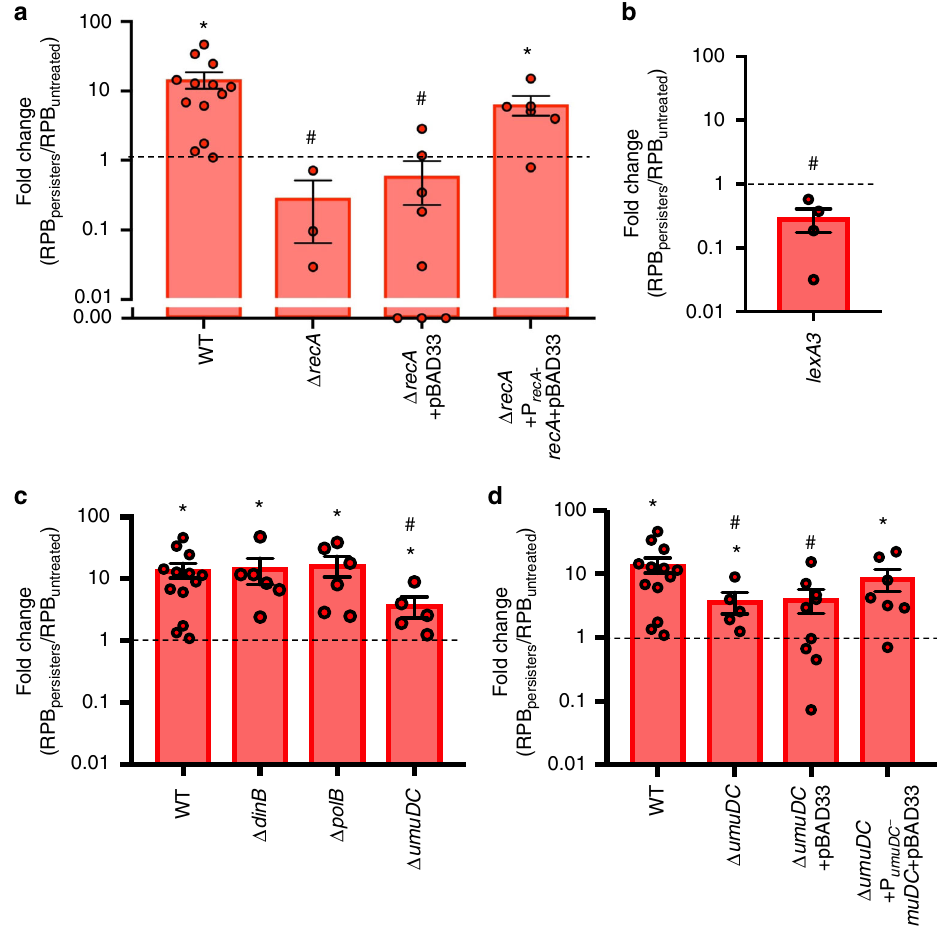
Fig. 4 Resistance enhancement involves RecA, SOS induction, and UmuDC. a OFL persisters derived from Δ recA ( n = 3), which is defective in SOS induction and recombinatorial repair, do not give rise to a population with increased RIF resistance. Complementation of Δ recA restores the enhancement of RIF-resistant mutants from OFL persisters ( n = 6), whereas persisters from Δ recA mutants bearing the pBAD33 control do not give rise to a population with enhanced RIF resistance ( n = 8). b Increase in RIF-resistant mutants was not observed in OFL persisters derived from lexA3 mutants ( n = 4), which cannot induce SOS. c Upon deleting umuDC , which encodes error-prone, SOS-induced DNA polymerase V, a signi fi cant increase in RIF-resistant mutants in OFL persister-derived populations was observed ( n = 5), but the magnitude of that increase was signi fi cantly lower than that of wild-type ( n = 13). Mutants lacking error-prone polymerase II ( Δ polB , n = 6) or error-prone polymerase IV ( Δ dinB , n = 6) had signi fi cant increases in RIF-resistant mutants in OFL persister-derived populations that were of a comparable magnitude as wild-type. d Complementation of UmuDC on pBAD33 in Δ umuDC mutants restores increase in RIF-resistant colonies from OFL persisters ( n = 7), whereas the presence of pBAD33 control fails to restore the phenotype ( n = 9). Error bars portray S.E.M. * indicates signi fi cance ( p ≤ 0.05) between log-transformed fold-changes and log-transformed value of 1 (fold-change of 1 would indicate no difference in resistant mutants). # indicates signi fi cance ( p ≤ 0.05, using two-tailed t -tests with unequal variances) between log-transformed fold-changes and those of wild-type. Zero values for Δ recA + pBAD33 were not included in the statistical analysis because they could not be